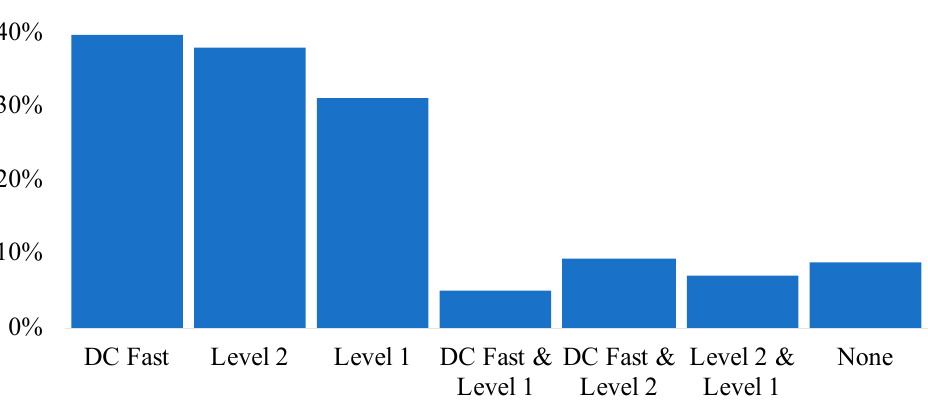
Figure 13. Distribution of TNC-PEV drivers across seven charging power clusters.